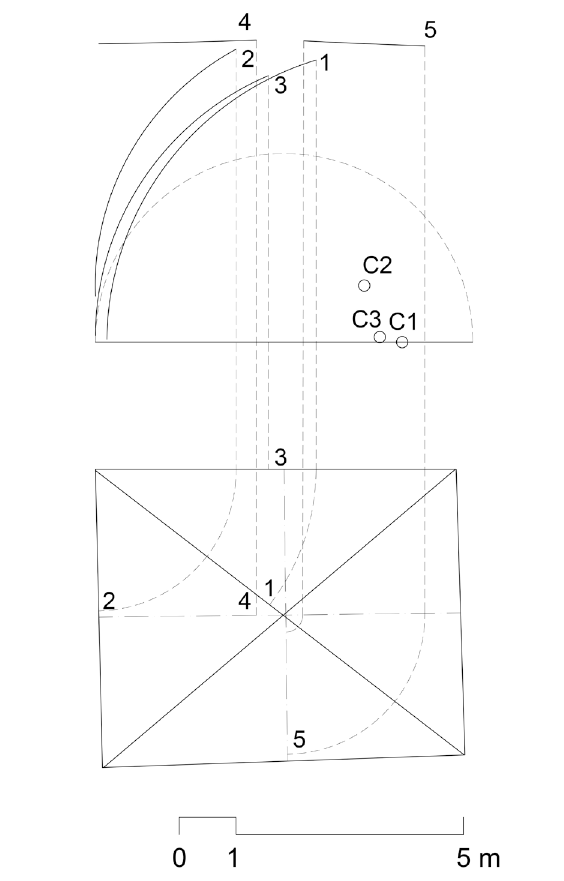
Figure 11 . Schematisation of the geometries of one of the vaults of San Miguel.